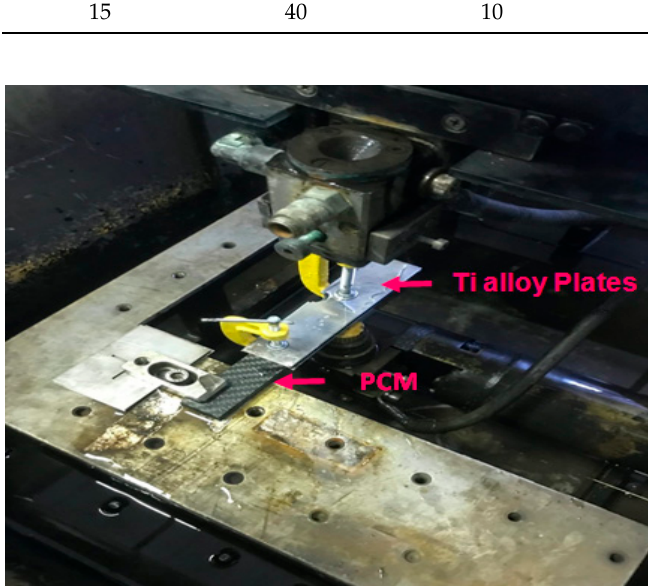
Figure 6. Pictorial view of PCM machining setup .